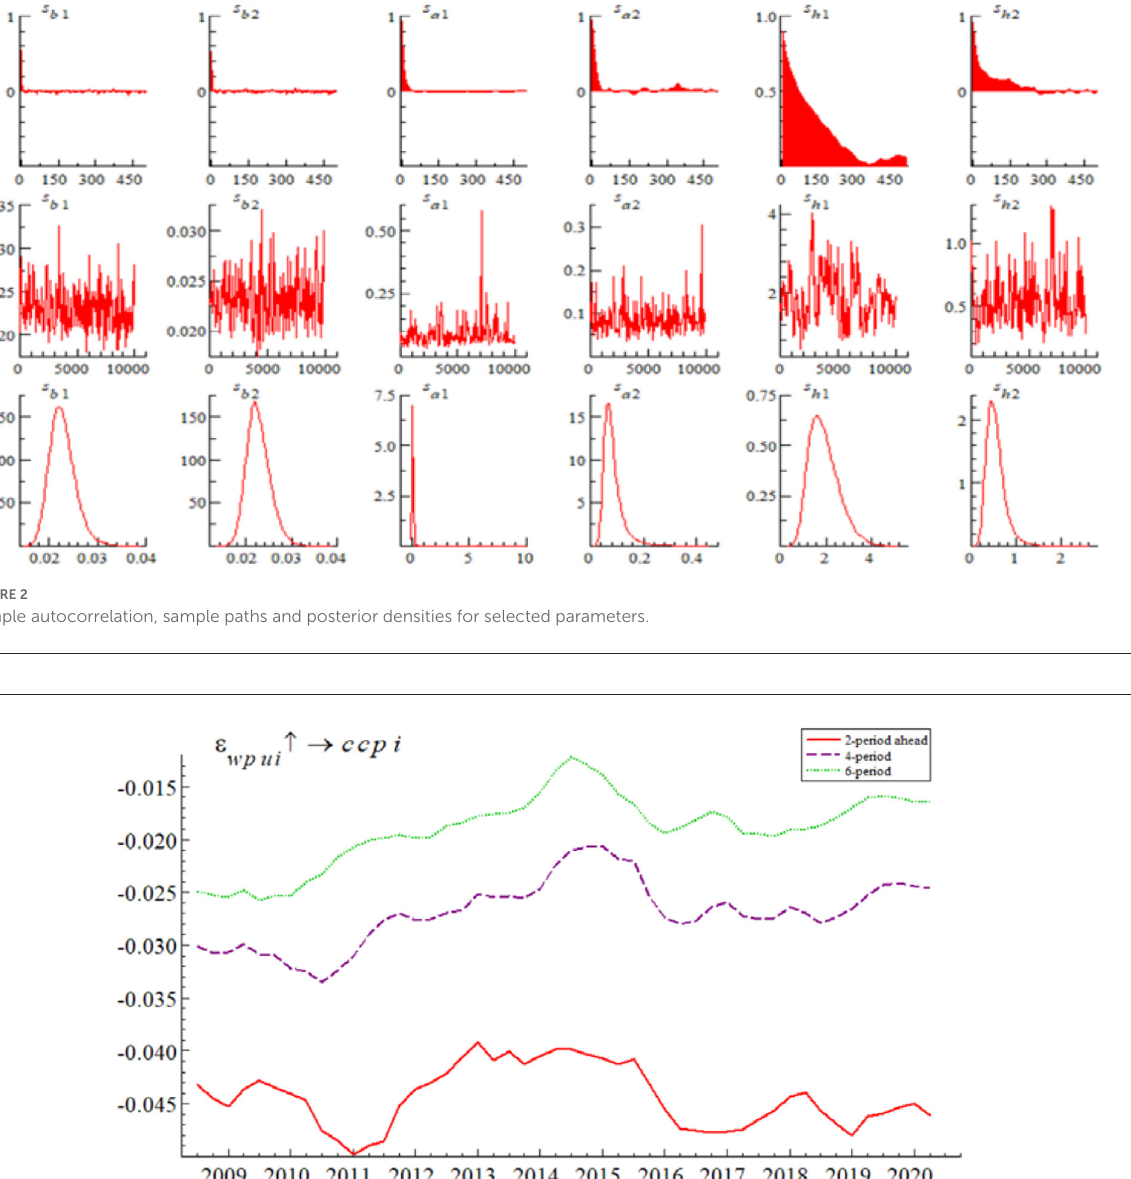
FIGURE3 Time-varying effects of WPU on China’s commodity prices. The red line represents the short-term impact, the purple line the medium-term impact and the green line the long-term